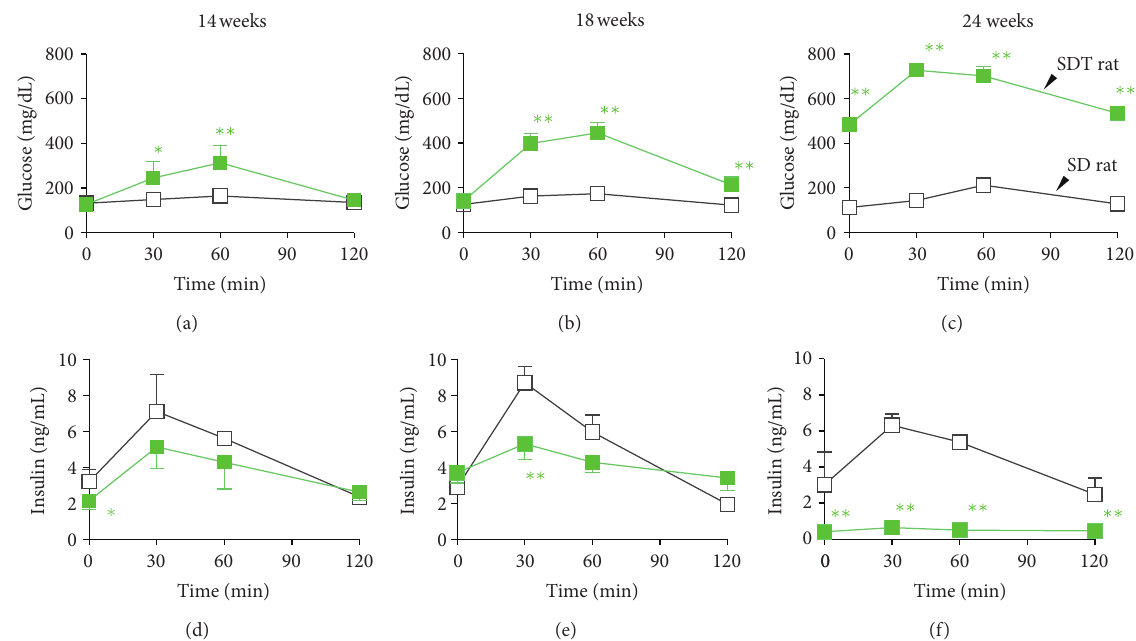
F 3: Oral glucose tolerance test (OGTT) in SDT rats. Changes in plasma glucose and insulin concentrations during OGTT (2g/kg). At 14 and 18 weeks, SDT rats were nondiabetic but the marked elevation of plasma glucose and lower insulin concentration were observed aer glucose loading. At 24 weeks, SDT rats were diabetic and showed further elevation of plasma glucose level because of diminished insulin secretion. White square: male SD rats, green square: male SDT rats. Data represent